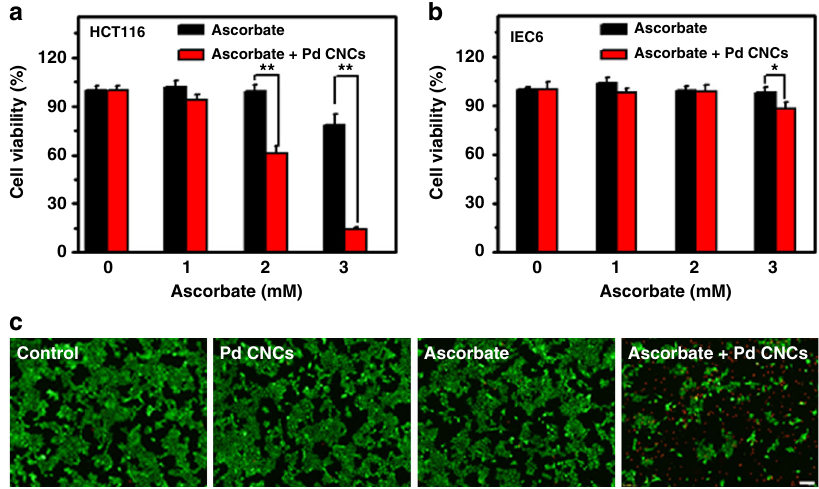
Fig. 5 Effects of Pd CNC-catalyzed ascorbate oxidation on the cytotoxicity. Cell viability of HCT116 cells ( a ) and IEC6 cells ( b ) treated with either 1-3 mM ascorbate or 50 μ g/mL Pd CNCs or combined ascorbate/ Pd CNCs for 24 h. Error bars were taken from three parallel experiments ( n = 3). P values compared to that of corresponding ascorbate alone treatment were calculated by Student´s t -test: * p < 0.05, ** p < 0.01. c Fluorescent images of live and dead stains of HCT116 cells exposed to 2.5 mM ascorbate plus 50 μ g/mL Pd CNCs. Scale bar = 100 μ